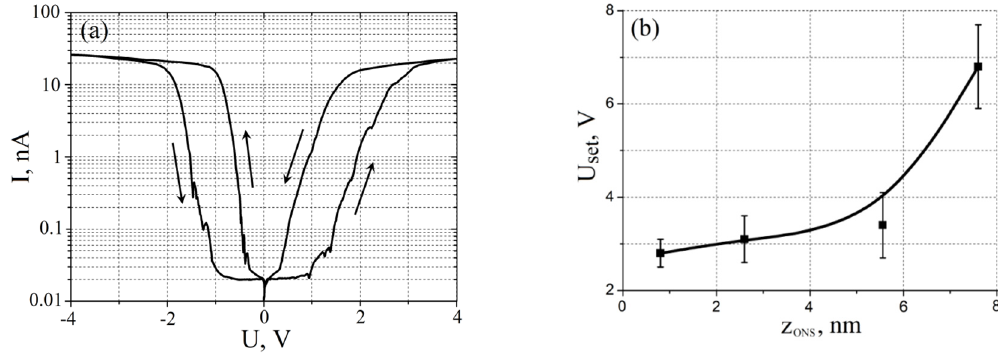
Figure 9. Investigation of resistive switching effect in of gallium arsenide ONS: ( a )— I-V characteristic of ONS; ( b )— U SET dependence on ONS thickness.